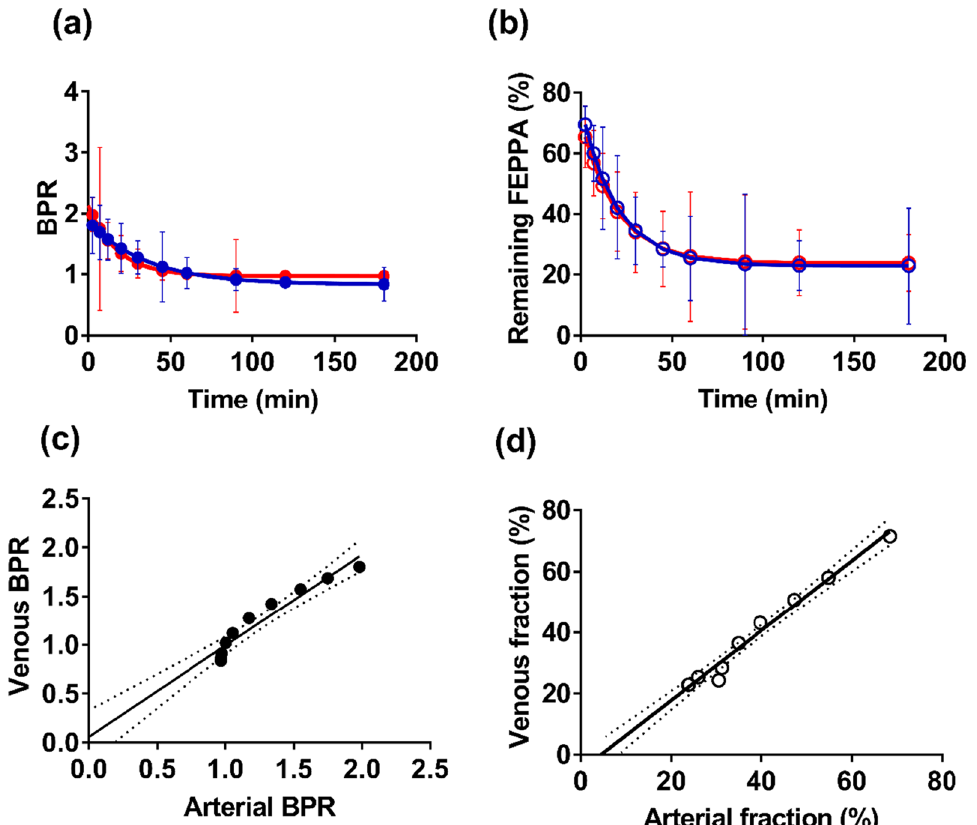
Fig. 4 a Blood-to-plasma ratios (BPRs) from arterial (red filled) and venous (blue filled) blood samples (results are from 8 animals). b Corresponding [ 18 F]FEPPA plasma percent determined from venous (blue hollow) and arterial (red hollow) samples. Each value represents the mean deviation and are presented for 10 time points ranging from 2.5 to 180 min. c Linear correlation between venous and arterial BPRs ( R 2 slope 0.94, intercept 0.06). d Correlation between remaining [ 18 F]FEPPA fraction from venous and arterial blood samples ( R 2 = = intercept 5.11). Note that figures c and d appear to show only nine points because of the overlap of two datasets (specifically at arterial = − BPR 0.97, venous BPR .85 and arterial fraction 24, venous fraction = = = =